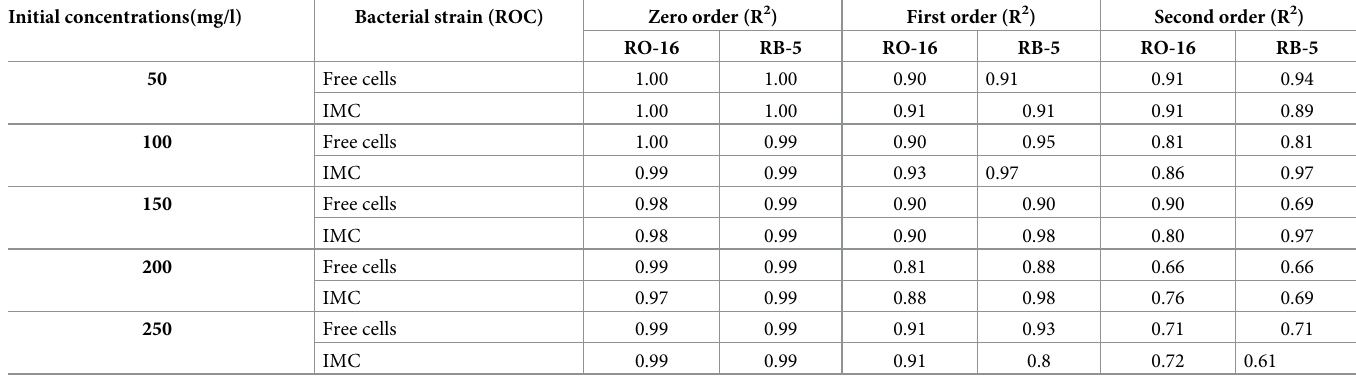
Table 1. Growth independent kinetic models for the azo dyes’ degradation at different initial concentrations.